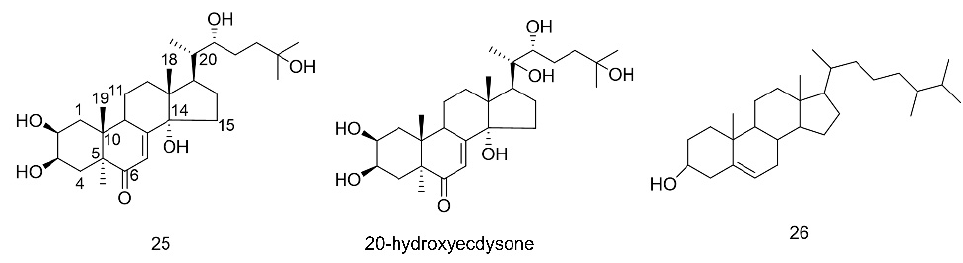
Figure 7. Steroids isolated from PA [57,67,68].